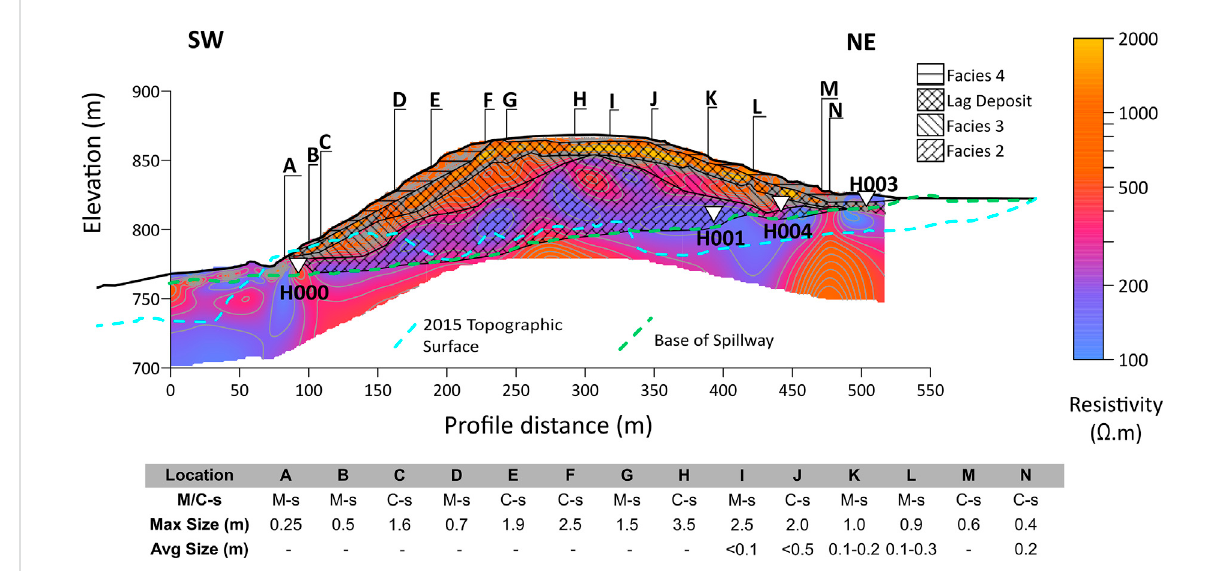
FIGURE 6 ERT results from the NE-SW pro fi le across the HRA dam. Hashed areas show facies (including the lag deposit at the boundary between Facies 3 and 4) identi fi ed in the dam face mapping (see Figure 4). Green dashed line is the base of the Spillway, blue dashed line is the pre-event 2015 topography attheSpillway. White triangles represent the PSD sample locations, projected ontothe pro fi le.Letters and table refer to aclast size pro fi le taken along the ERT line on the surface of the dam. M-s, matrix-supported, C-s, clast-supported, max size, maximum particle size observed at surface along pro fi le, avg size, average particle size observed at surface along pro fi le. See Figure 1A for survey line